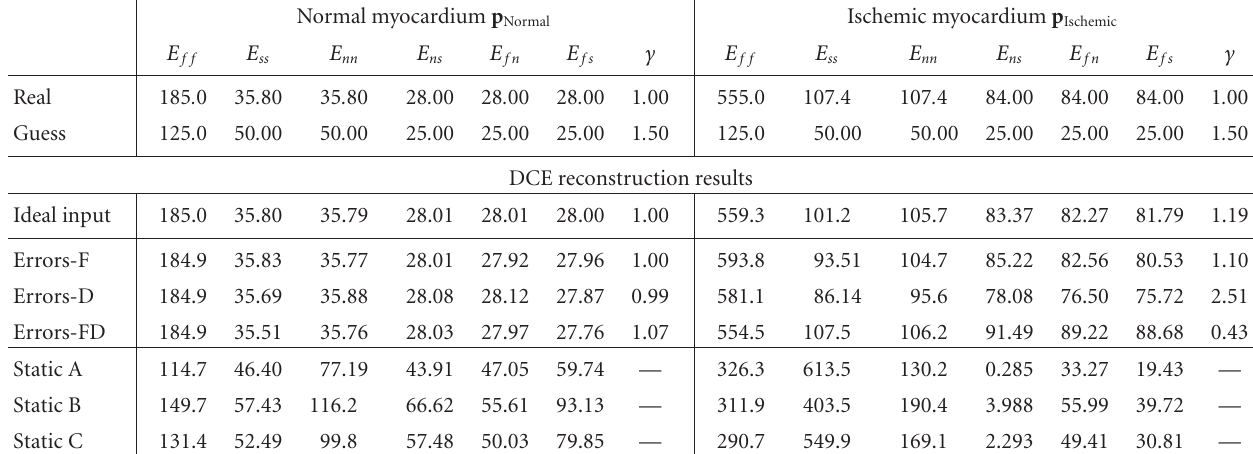
Table 1: Guesses and reconstruction results for dynamic cardiac elastography: passive parameters. Normal myocardium p